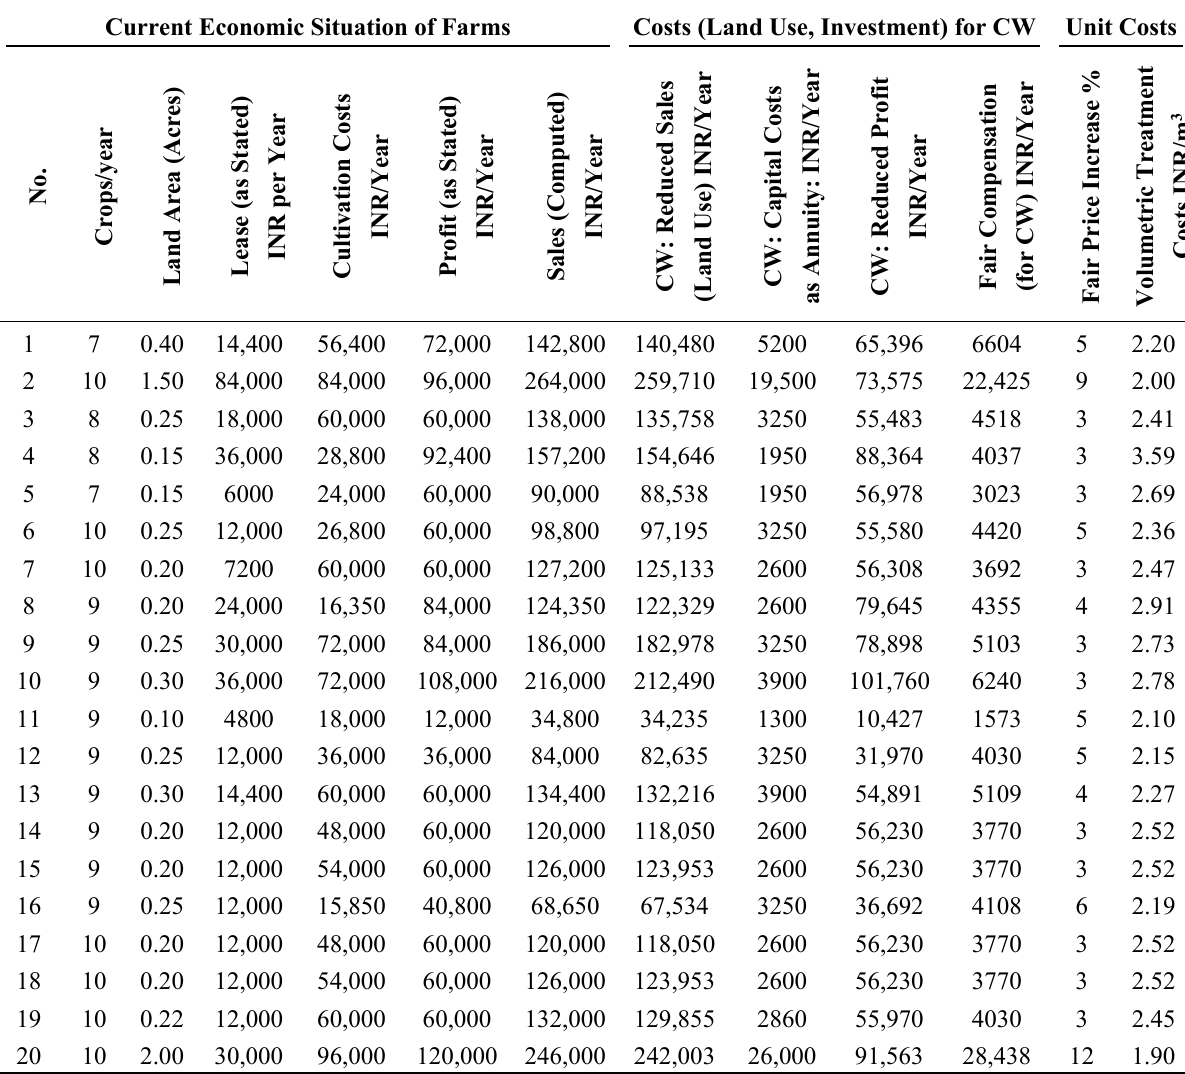
Table 7. Economic situation of the farms in the study area and impact of irrigation costs. Current Economic Situation of Farms Costs (Land Use, Investment) for